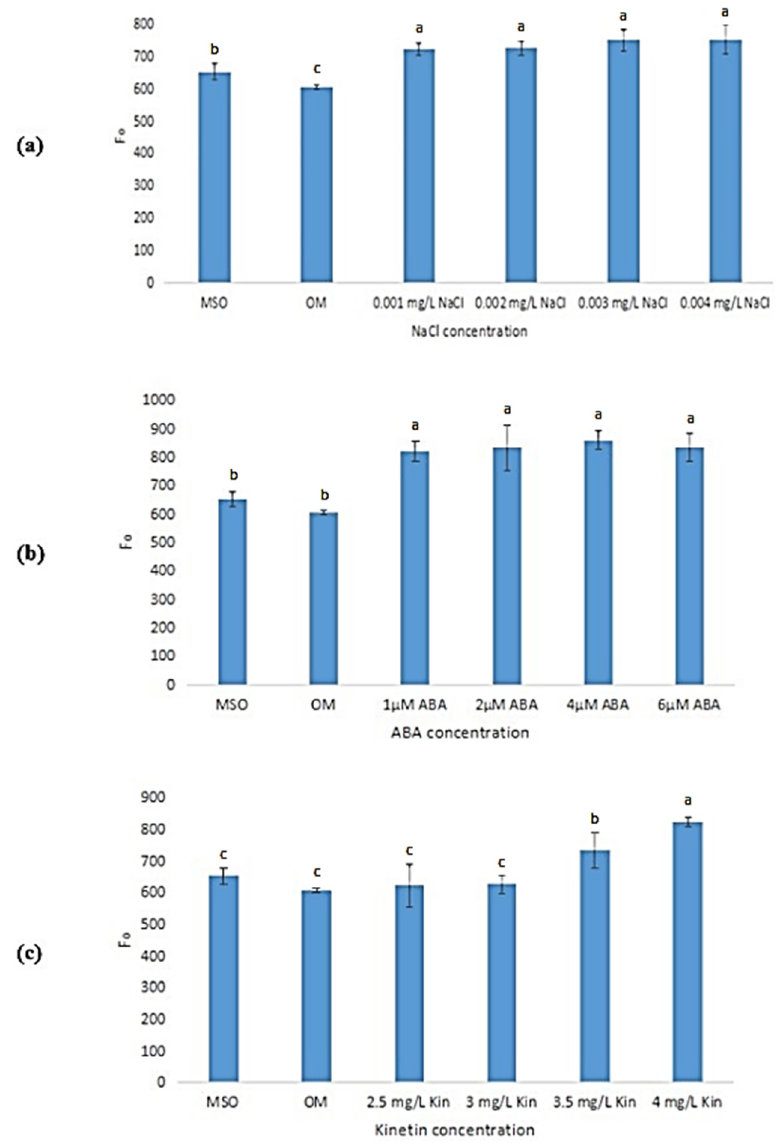
Figure 16. Minimal fluorescence (F o ) of plants exposed to: ( a ) salt stress; ( b ) ABA; ( c ) high kinetin levels. Means with different letters are significantly different at p < 0.05 according to Duncan’s multiple range test (DMRT).